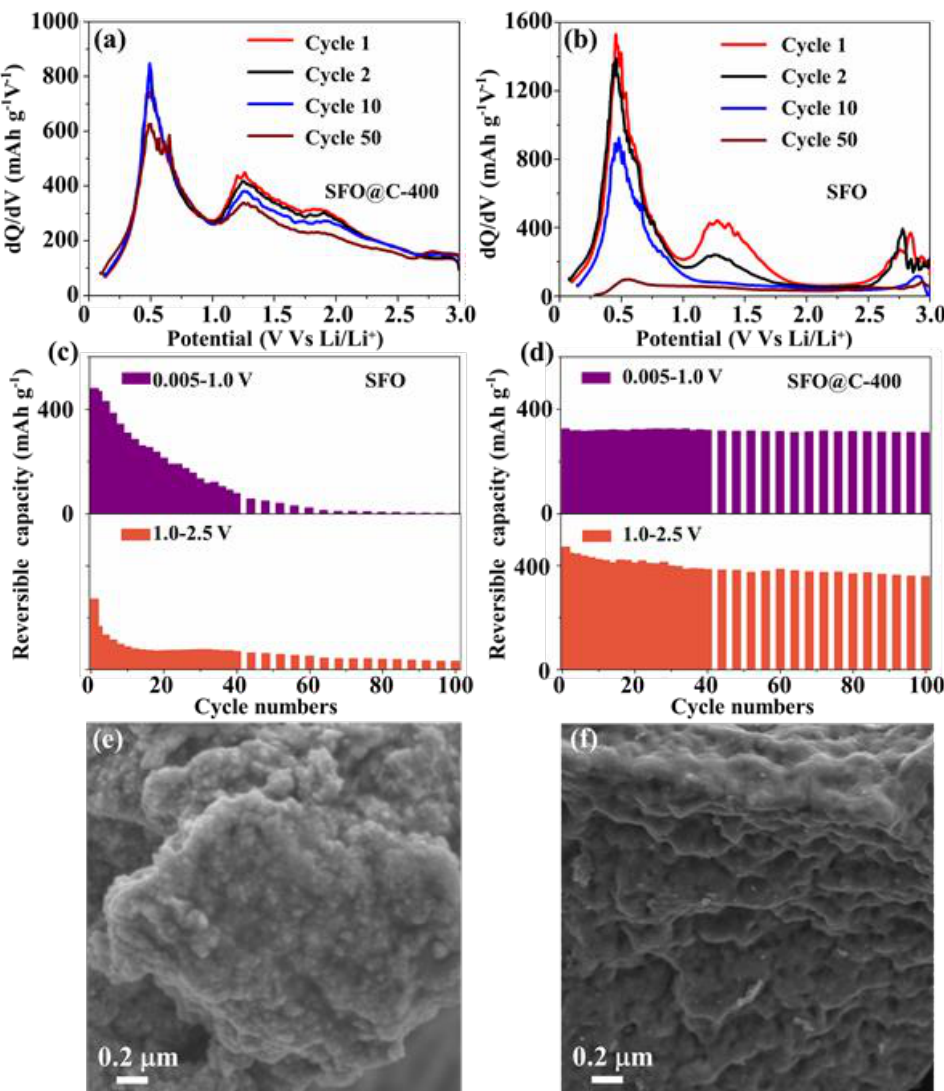
Figure 5. Differential charge capacity curves at 0.2 A/g of (a) the SFO@C-400 electrode and (b) the SFO electrode at the 1st, 2nd, 10 th , and 50th cycle; reversible capacities versus cycle number of (c) the SFO electrode and (d) the SFO@C-400 electrode separated into potential ranges of 0.005–1.0 V and 1.0–2.5 V; SEM images of the SFO@C-400 electrode (e) before and (f) after 100 cycles at 0.2 A/g.